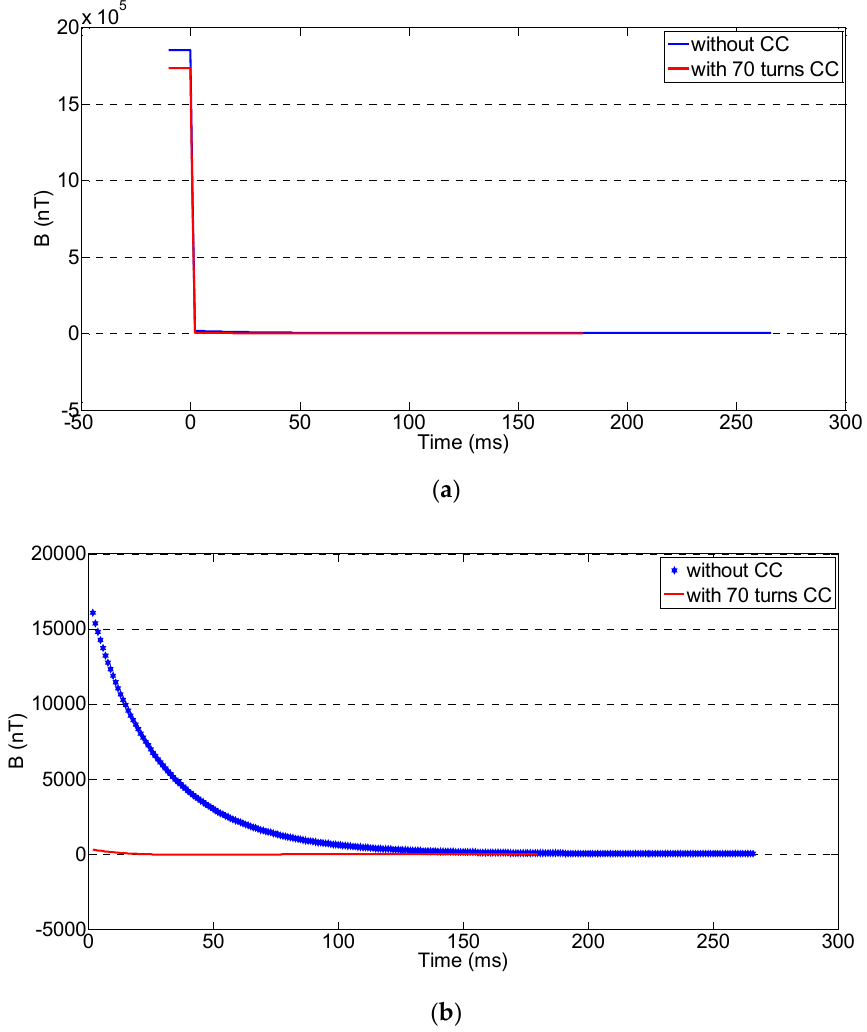
Figure 2. Comparison of residual magnetic field component in z direction without and with CC. ( a ) Decay curves of magnetic field in the SR; ( b ) decay curves of eddy current field after t s = 2 ms. Simulation results in Figure 2 are detailed in Table 2. Table 2. B r without CC and with 70 turns CC at different times.